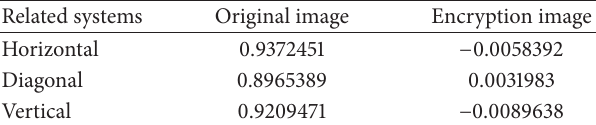
Table 4: The correlation among adjacent pixels of R